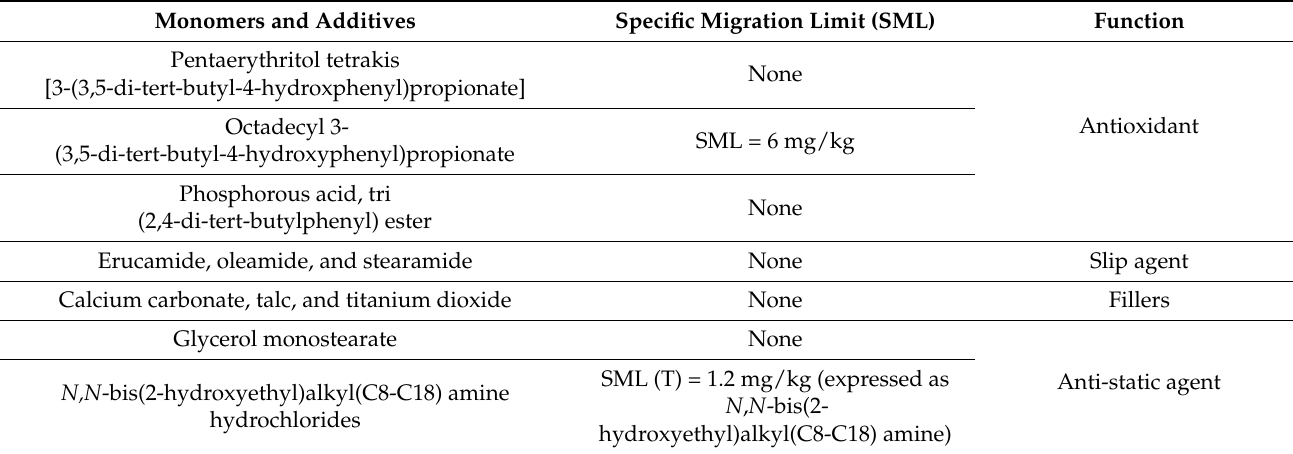
Table 7. Monomers and additives used in PE manufacturing for food packaging. Adapted from page 14 in reference [169].